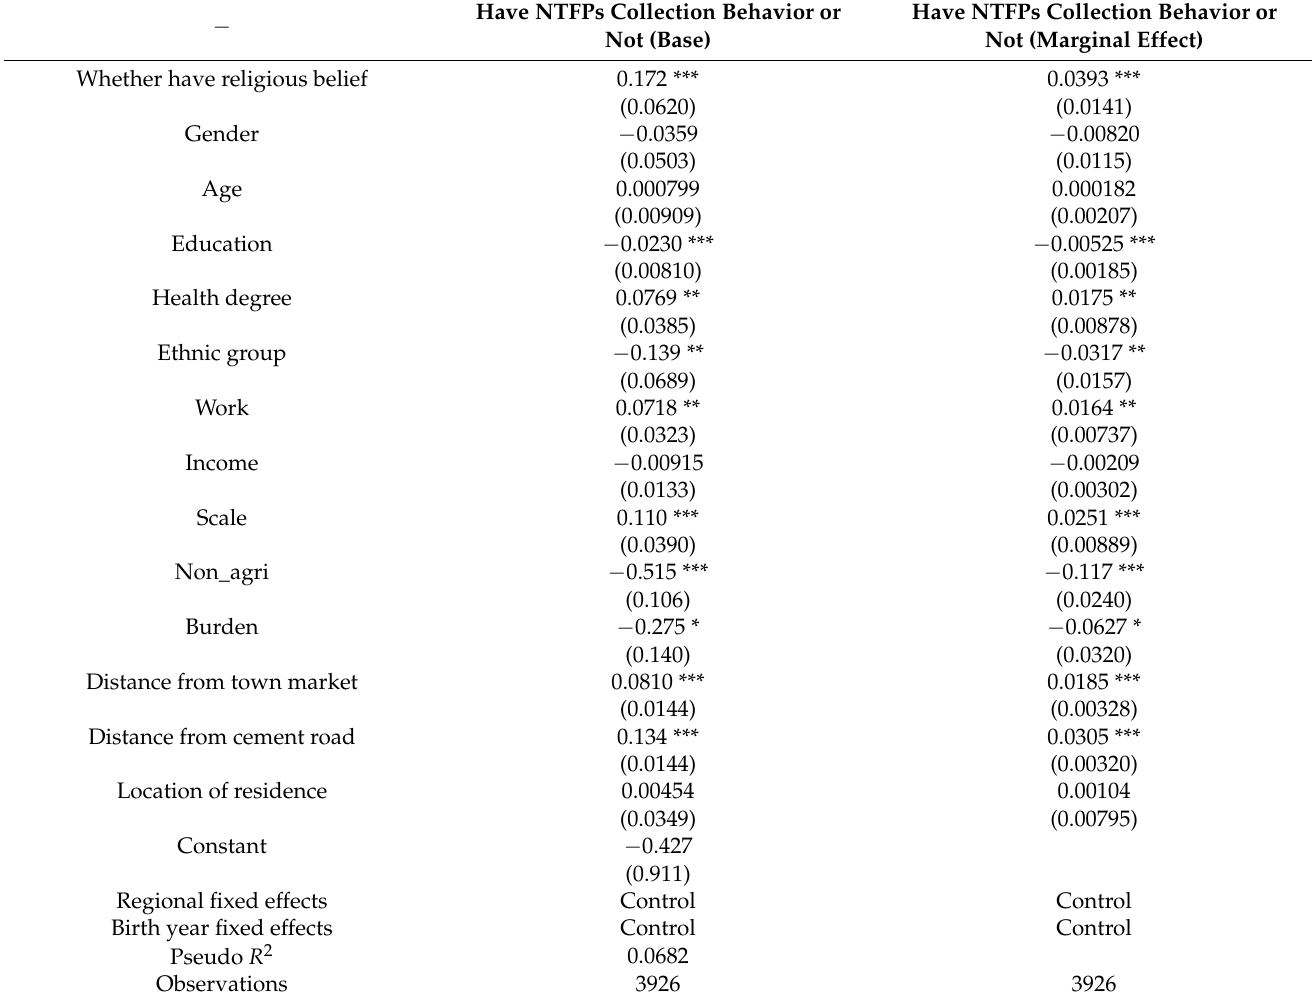
Table 5. The baseline regression for religious belief and NTFPs collection